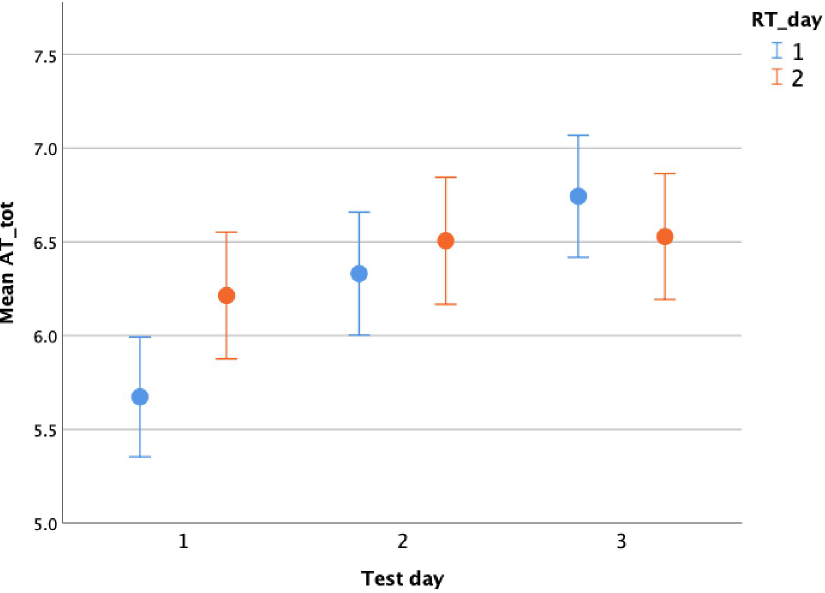
Fig 1. Test day and RT_day plot. Average approach test score (AT_tot: Circles and whiskers = mean and standard error bars) across the three test days with respect to the reactivity test administration day (RT_day).